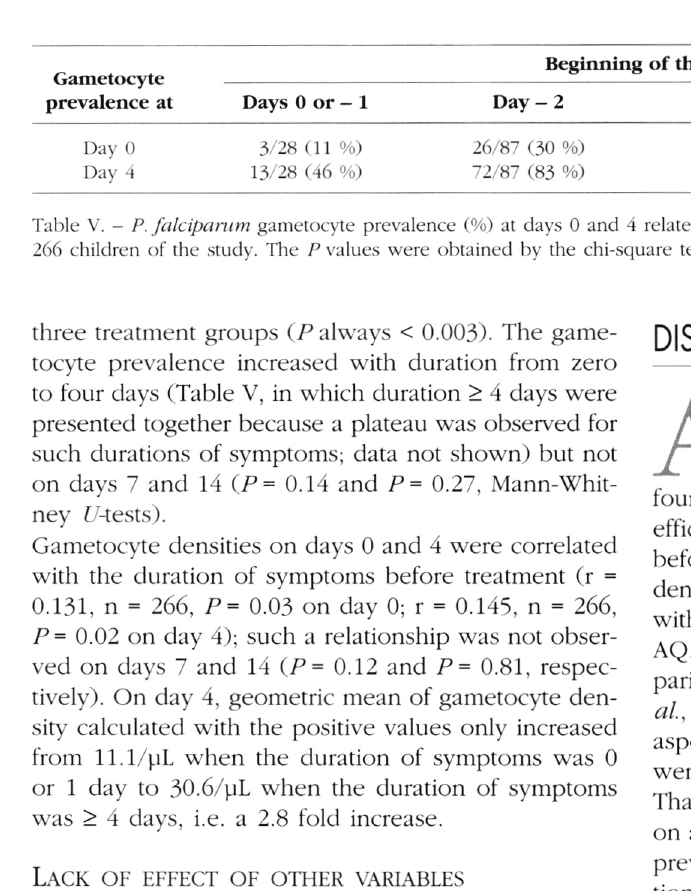
three treatment groups ( P always < 0.003). The game­ tocyte prevalence increased with duration from zero to four days (Table V, in which duration ≥ 4 days were presented together because a plateau was observed for such durations of symptoms; data not shown) but not on days 7 and 14 (P = 0.14 and P = 0.27, Mann-Whit­ ney U